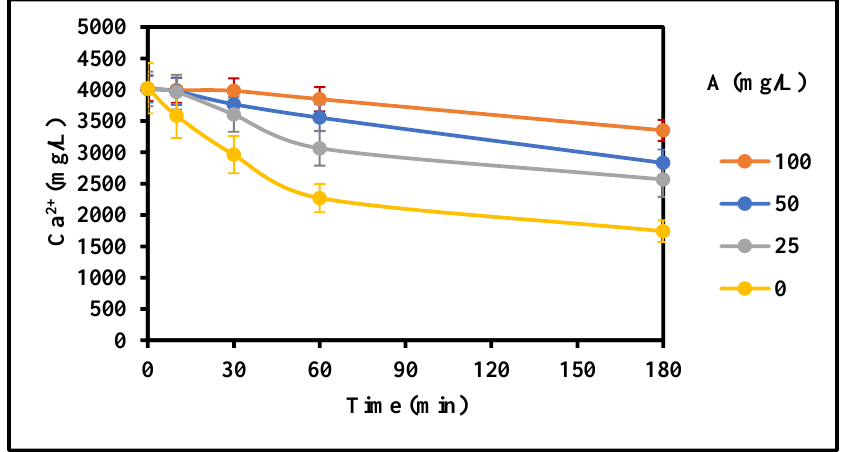
Figure 9. Effect of inhibitor A concentration on the rate of gypsum crystallization with initial mixing (4000 mg/L CaSO 4 (as Ca), 0 g/L gypsum seed, 4 g/L Fe 3+ , 0 – 100 mg/L Inh. A, 25 °C, stirring rate: 200 rpm; Stirring time (min): 5/180).